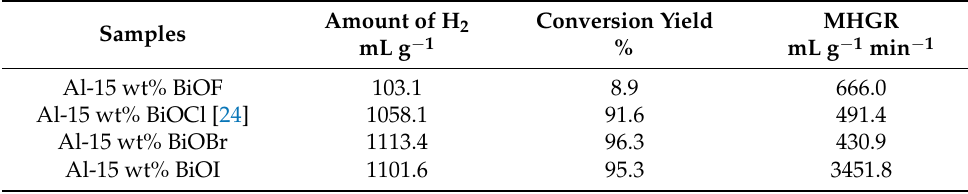
Table 1. Hydrogen generation performances of Al-15 wt% BiOX (X = F, Cl, Br and I).